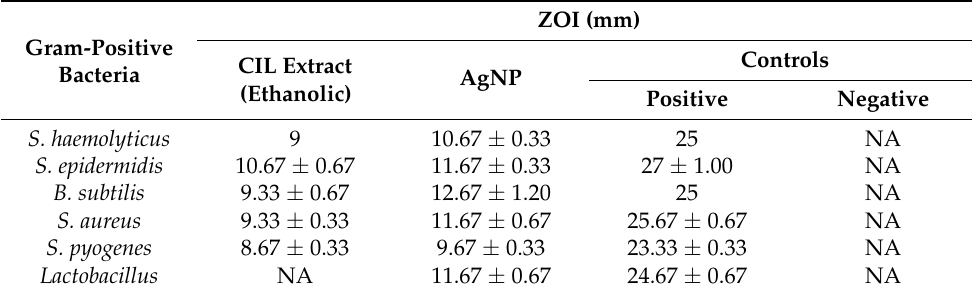
Table 2. Antibacterial activity of CIL ethanolic extract and synthesized AgNPs against Gram-positive bacteria.